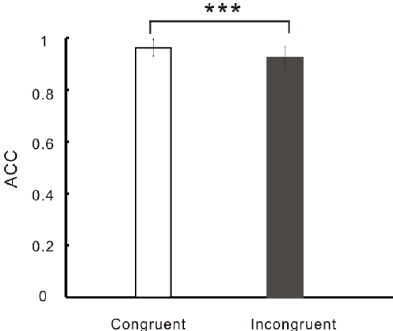
Figure 4. Accuracy (ACC) difference between congruent and incongruent trials in the color– word Stroop task (*** p < 0.001).